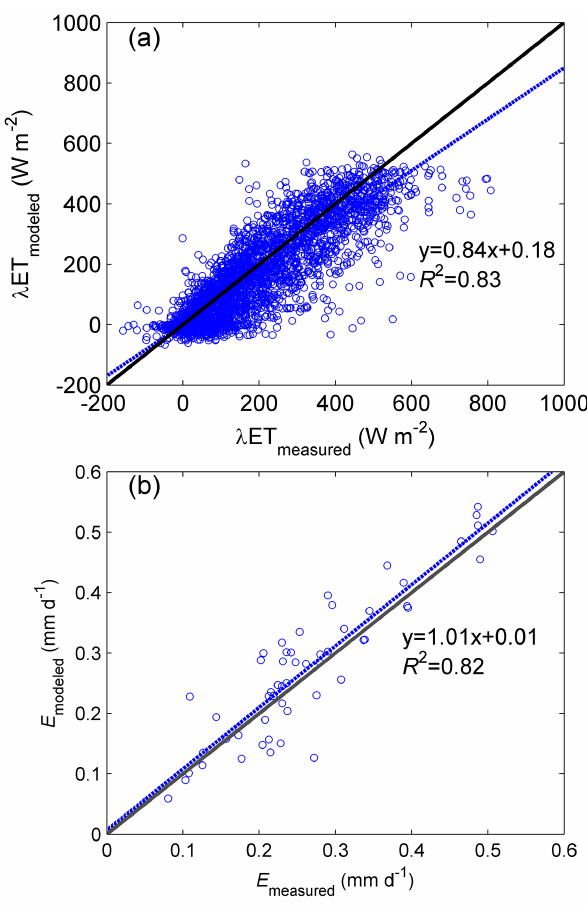
Figure 7. (a) Plot of estimated evapotranspiration ( λ ET; Wm − 2 ) against observed values. The regressions is y = 0 . 84 x + 0 . 18 ( R 2 = 0 . 83 ) ; (b) Plot of estimated daily soil evaporation ( E ; mmday − 1 ) against measured data. The regressions is y = 1 . 01 x + 0 . 01 ( R 2 = 0 . 82 )